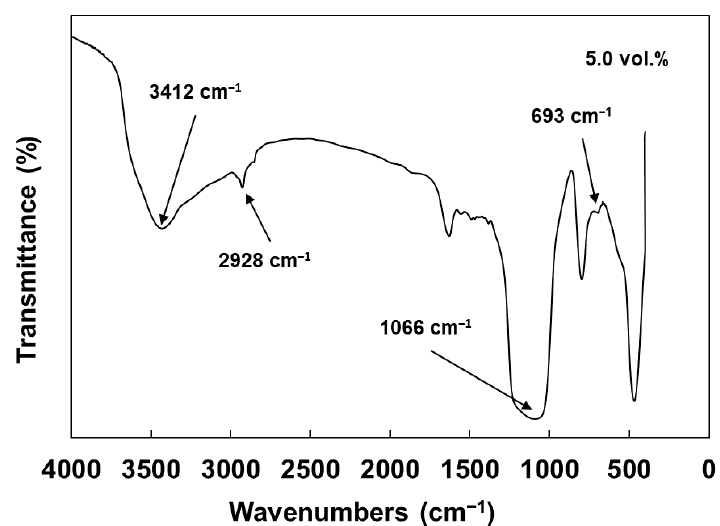
Figure 3. FTIR spectra of grafted NH 2 -Al/MCM-41 with 5.0 vol.% amine functional groups.